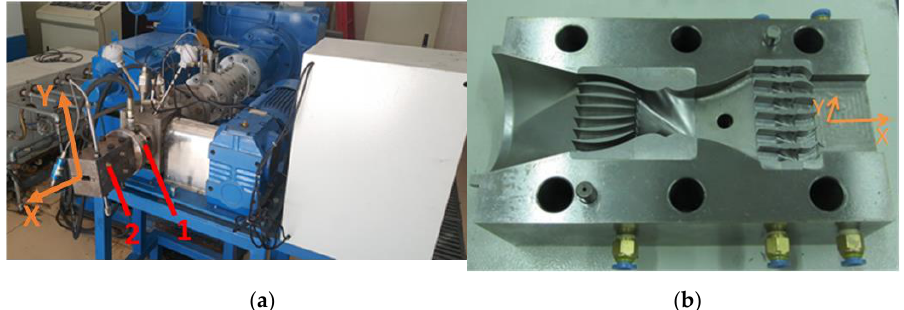
Figure 5. ( a ) Short-fiber radial orientation direction: 1 is referred to Herringbone gear pump, 2 is referred to orientation die; ( b ) Structure of orientation die.